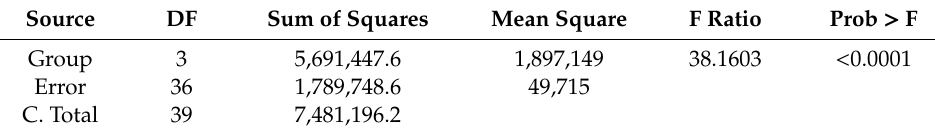
Table 5. One-way ANOVA test, failure load of repaired veneered zirconia crowns. Source